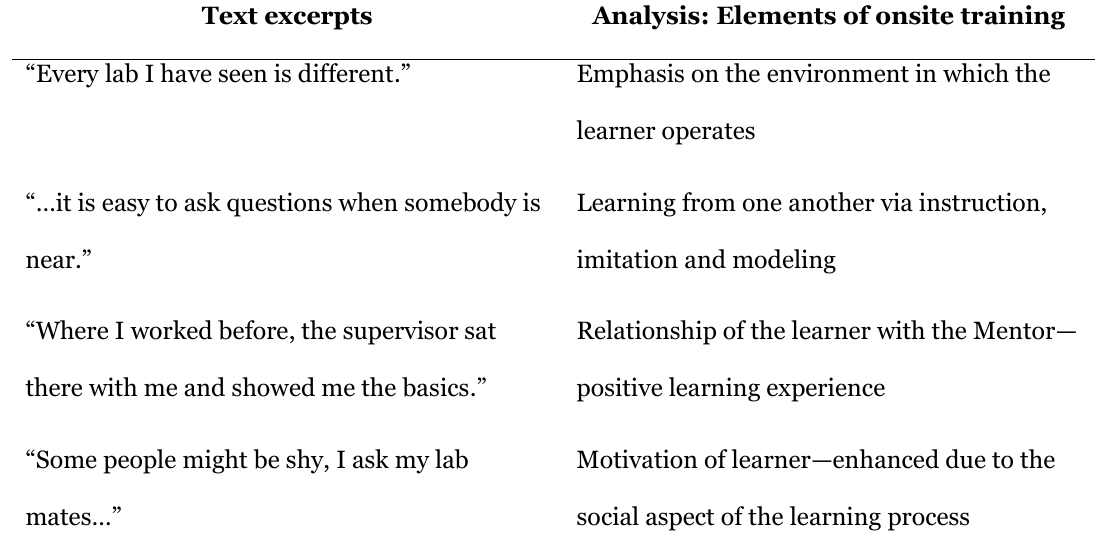
Data Analysis Example: Onsite Training Text excerpts